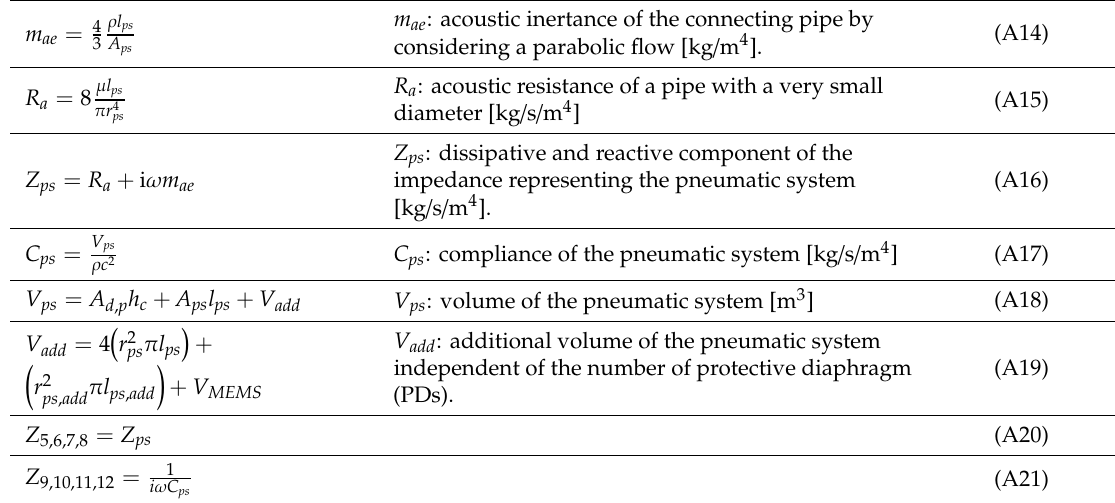
Table A4. Lumped parameter model for the acoustic impedance of the pneumatic system connecting the protective and the MEMS microphone’s (MEMS MIC’s) diaphragm [kg / s / m 4 ], [23]. ρ l ps m ae = 4 A ps 3